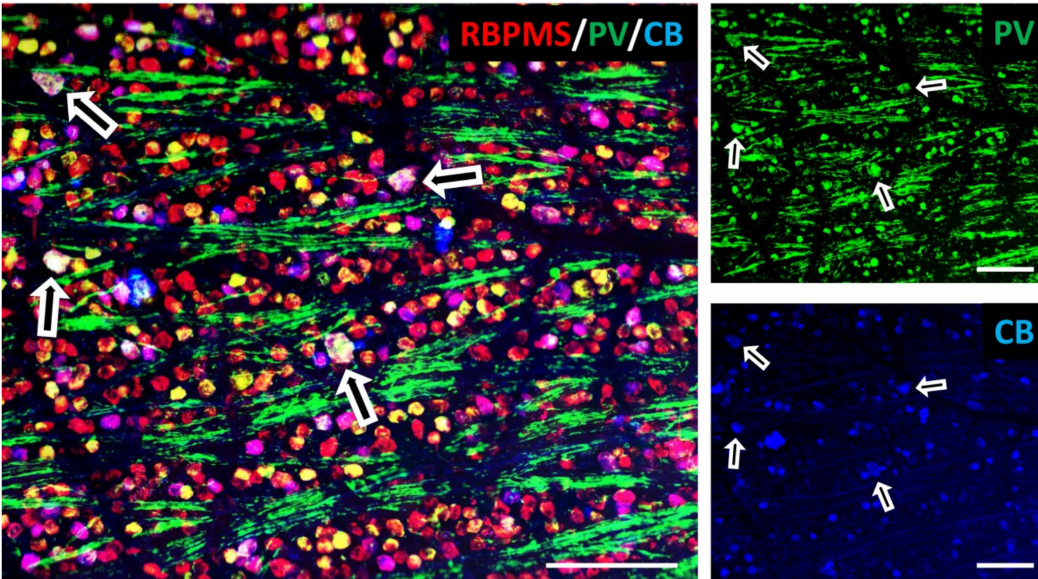
Figure 1. Retinal whole-mount from a Brown Norway rat labelled with antibodies against RNA-binding protein with multiple splicing (RBPMS, red; #ABN1376, Millipore, Darmstadt, Germany; 1:250) to identify retinal ganglion cells; and the calcium-binding proteins parvalbumin (PV, green; #P3088, Sigma-Aldrich, St. Louis, MO, USA; 1:200) and calbindin (CB, blue; #300, Swant Inc., Marly, Switzerland; 1:200). Individual color channels are shown as indicated. White arrows indicate retinal ganglion cells expressing both parvalbumin and calbindin. Scale bar = 100 µ m. All experiments involving animal use were performed in compliance with the relevant laws and institutional guidelines of Baden-Württemberg, Germany. Previously unpublished data